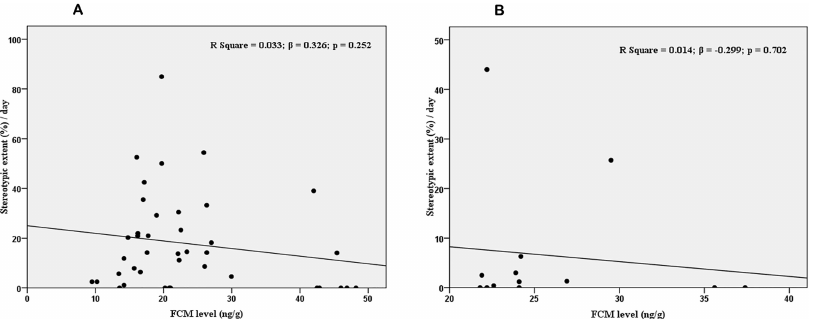
Fig 2. Relationship betweenFCM and stereotypic behaviouramong(2A) tigers and (2B) leopards.